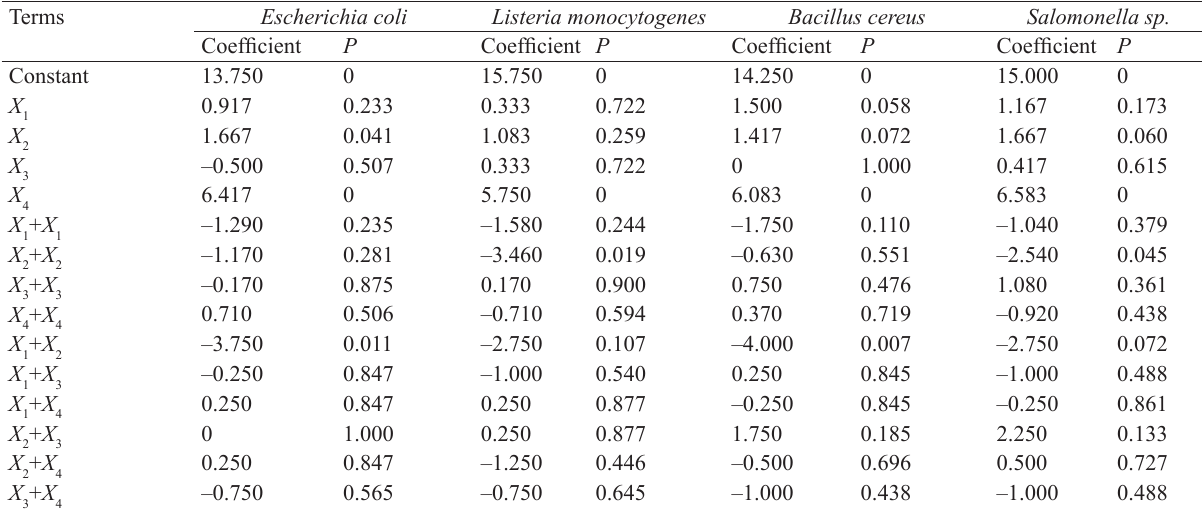
Table 2 ANOVA results and coefficients of mathematical model of inhibition zones for Lactobacillus fermentum and Bifidobacterium bifidum on Escherichia coli , Listeria monocytogenes , Bacillus cereus, and Salmonella sp. Terms Escherichia coli Listeria